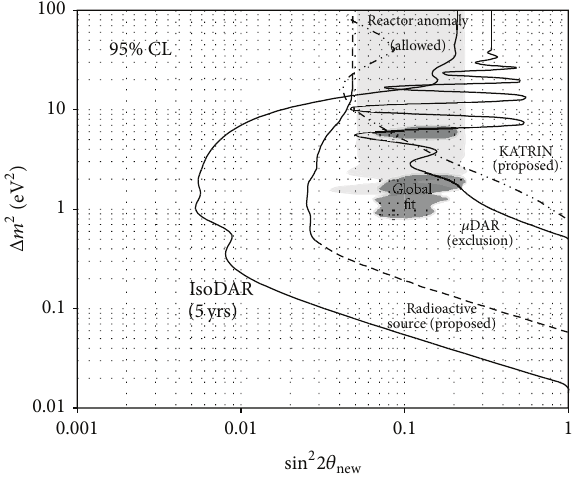
Figure 8: Sensitivity of IsoDAR in a nominal 5-year run, in com- parison with other experiments. The existing 𝜇 DAR [19] exclusion curve and Reactor + Gallium [20] allowed region are also